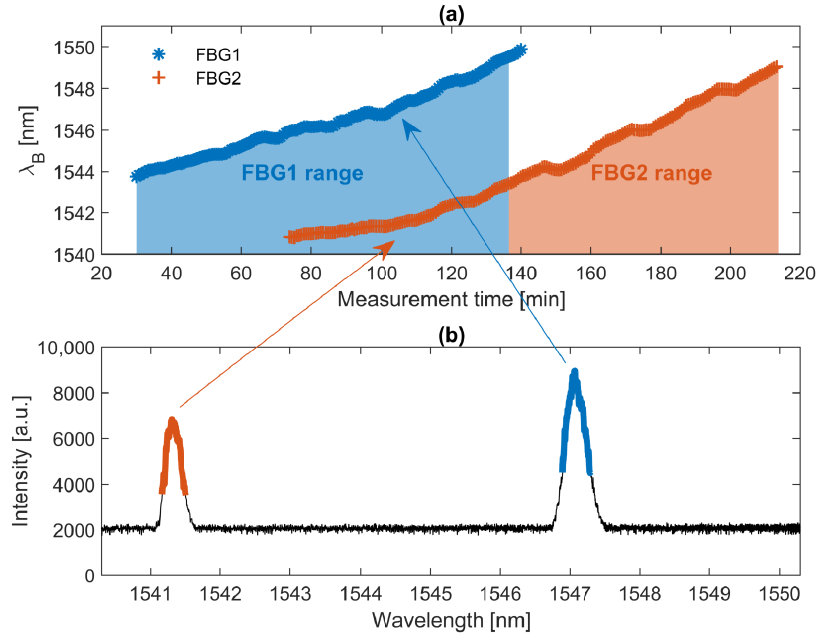
Figure 12. ( a ) Relation between the calculated central wavelength of the FBG sensors and the time of measurement. The asterisk curve represents the data from FBG1, and the plus sign line is for FBG2. ( b ) The spectrum obtained with the proposed interrogator for a temperature equal to circa 350 ◦ C (the equivalent of the 105th minute of